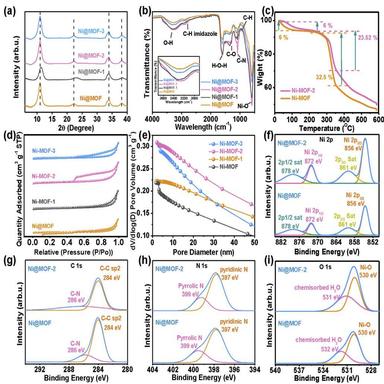
(a) XRD patterns of Ni-MOF, Ni-MOF-1, Ni-MOF-2, and Ni-MOF-3 samples (b) FT-IR spectra of Ni-MOF, Ni-MOF-1, Ni-MOF-2, and Ni-MOF-3 samples (inset shows the magnified portion of eOH stretching vibrations), (c) TGA analysis curve of Ni-MOF and Ni-MOF-2, (d) N2 adsorption-desorption isotherms of Ni-MOF, Ni-MOF-1, Ni-MOF-2, and Ni-MOF-3 samples, (e) pore size distribution of Ni-MOF, Ni-MOF-1, Ni-MOF-2, and Ni-MOF-3 samples, and (fei) High-resolution XPS spectra of Ni 2p, C 1s, N 1s, and O 1s regions for Ni-MOF